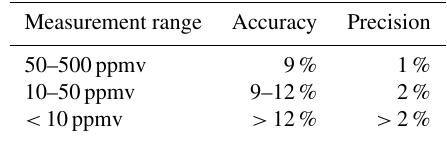
Table 1. Measurement range, accuracy and precision for the CR-2